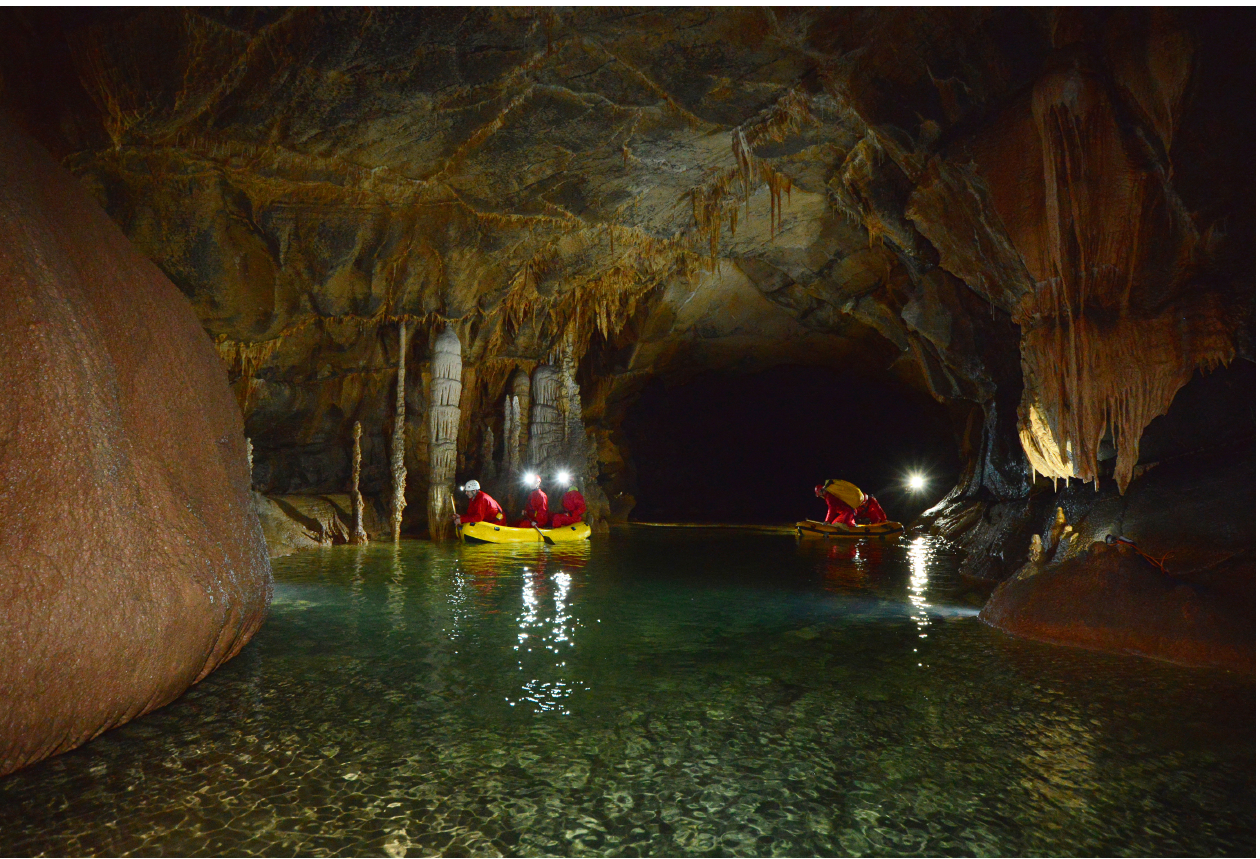
Figure 1. The unique features of Križna jama are its breathtaking clean and emerald green subterranean